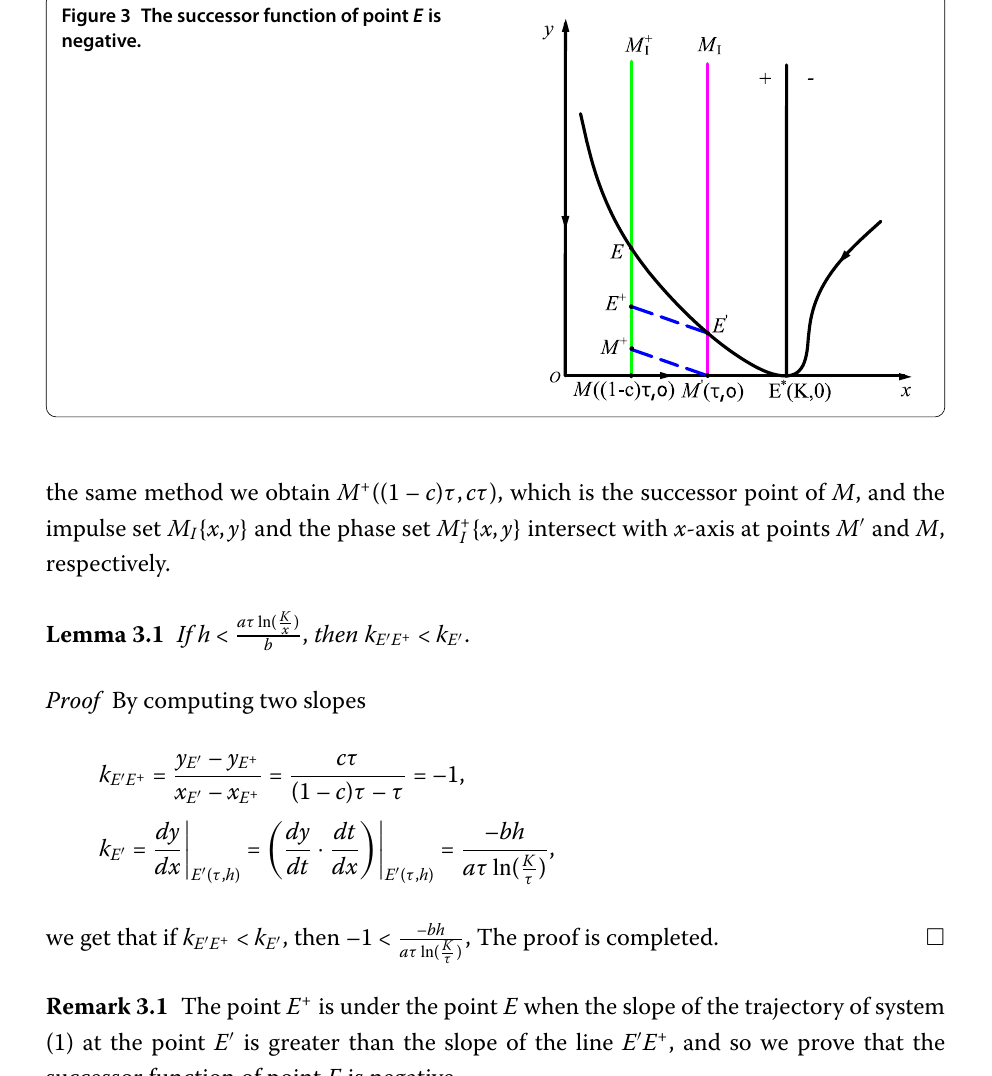
Figure 3 The successor function of point E is